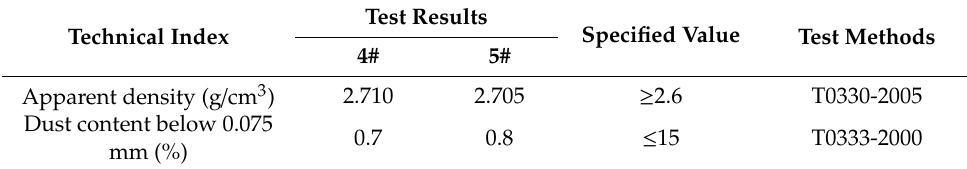
Table 3. Technical indexes of fine aggregates.